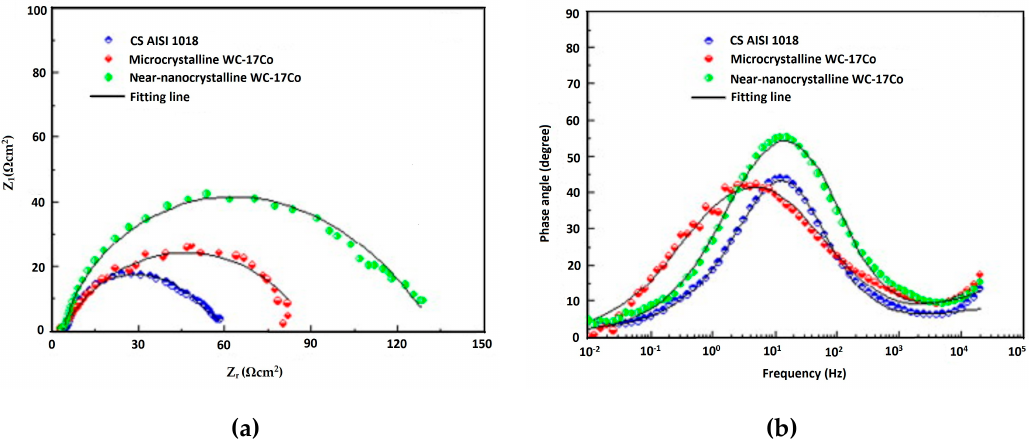
Figure 9. Electrochemical impedance spectroscopy (EIS) of near-nanocrystalline WC–17Co, microcrystalline WC–17Co coatings, and uncoated steel exposed to fluid flow (sand particles in 3.5 wt. % NaCl with 1000 ppm (~0.001 wt. %) NaHCO 3 solution): ( a ) Nyquist diagrams and ( b ) Bode plots [114]. Reprinted with permission from ref [114]. © 2011 Elsevier.